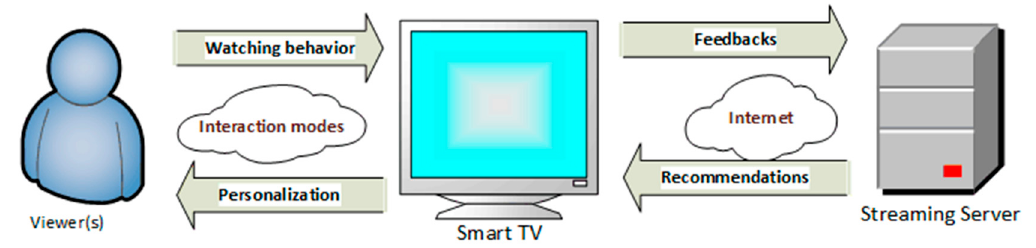
Figure 1. General scenario of recommendation process on a smart TV.